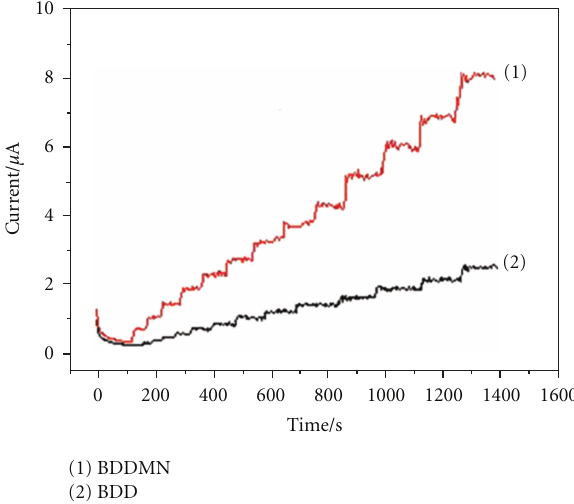
Figure 3: Current-time responses of the BDD electrode (1) and the BDDMN electrode (2) through successive addition of UA (each step of the curves indicates 0.013, 0.026, 0.04, 0.052, 0.064, 0.076, 0.088, 0.1, 0.15, 0.2, 0.25, 0.3, 0.35, and 0.4 mM from low to high) in 0.1 M PBS solution at an applied potential of 0.4 V (versus SCE, for both electrodes, the oxidation current response occurs at 0.4